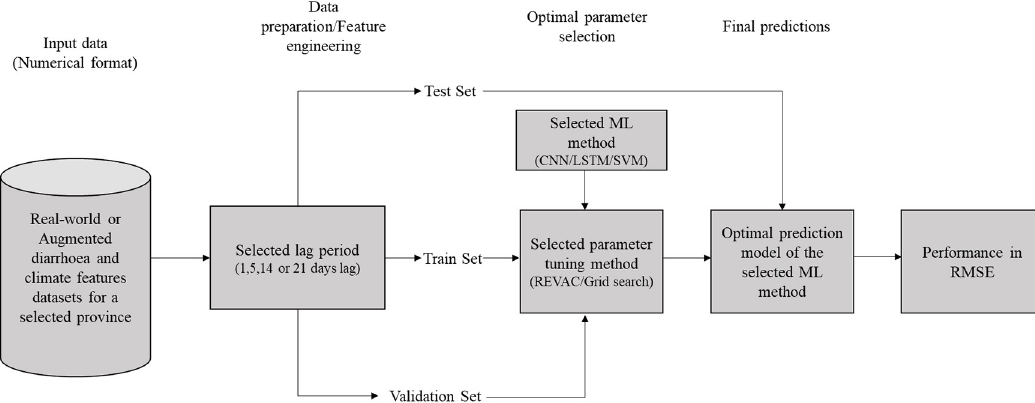
Fig 5. Pipeline of the daily diarrhoea prediction model.